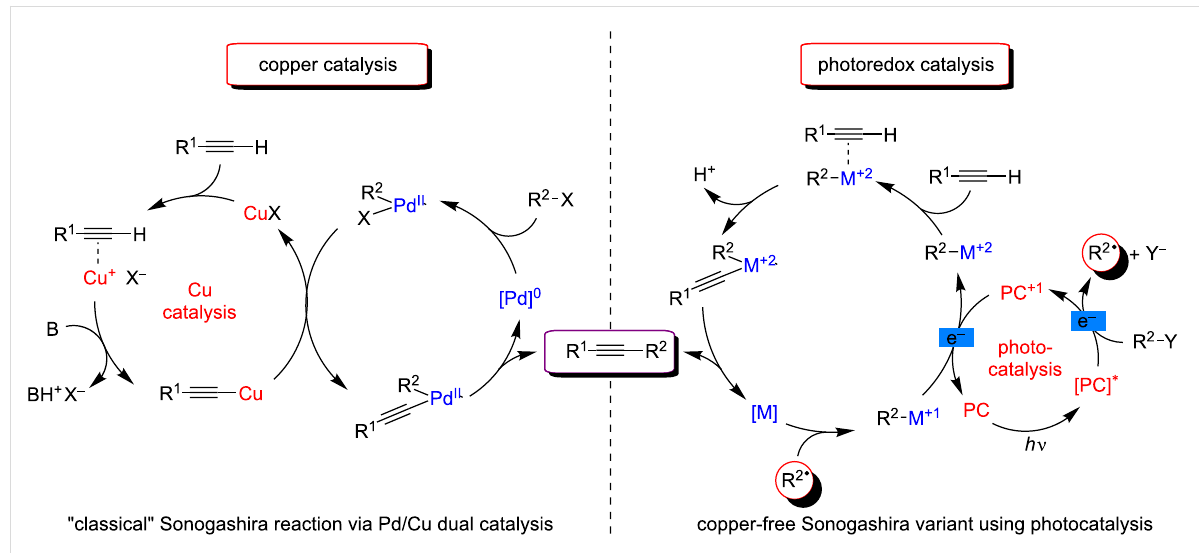
Figure 50: General mechanisms for the “classical” (left) and Cu-free variant (right) Sonogoshira